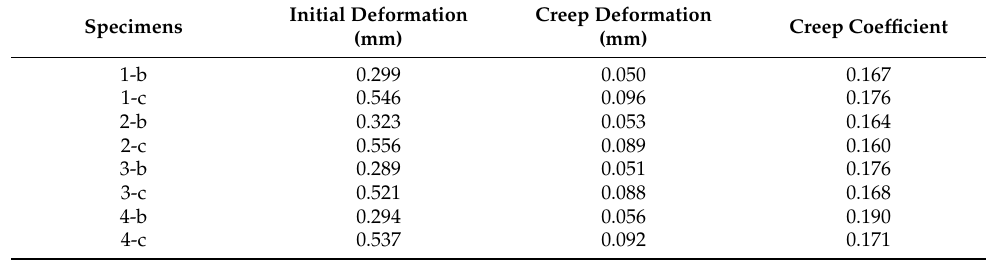
Figure 8. Creep-time curves under the same load level (with initial displacement): ( a ) The load level of 40%Ny; ( b ) The load level of 70% Ny.